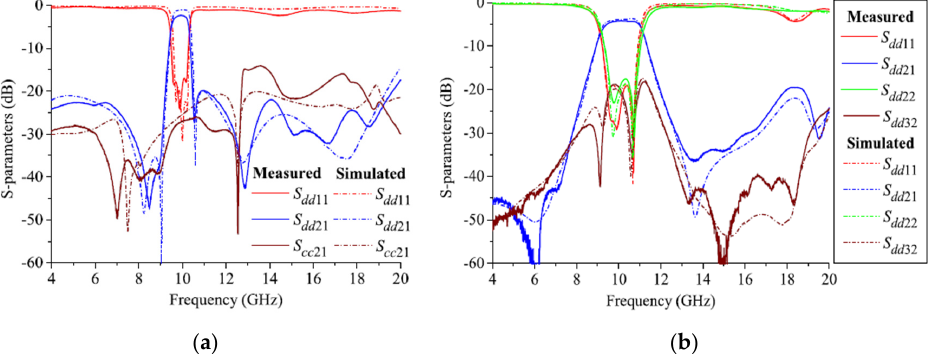
Figure 4. Simulated and measured s-parameters of the proposed design [45]: ( a ) Balanced BPF performance; ( b ) Balanced-to-balanced filtering power divider performance.